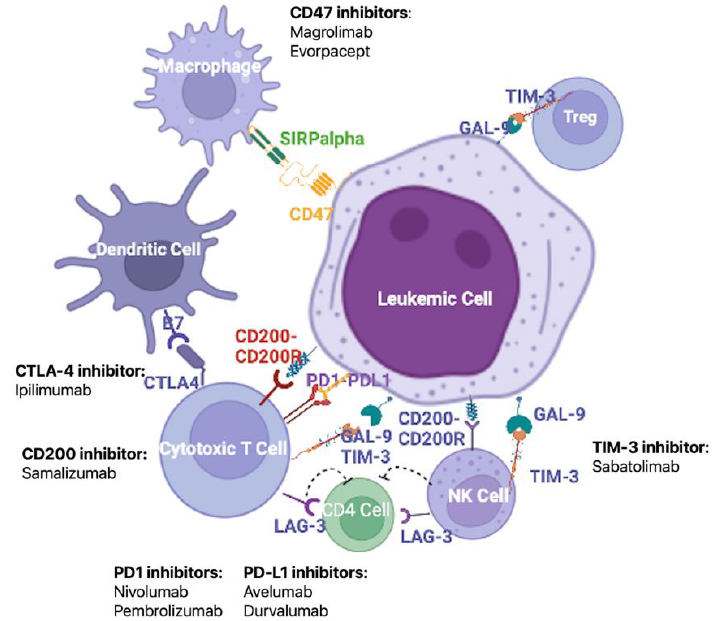
Figure 2. Major mechanisms of the maintenance of immune tolerance and potential therapeutic targets. Given the pivotal role of LSC-induced immune escape in the development and relapse of AML, an important treatment strategy to restore the function of anti-tumor immune cells is the blockade of immune checkpoints by monoclonal antibodies. Among the most promising targets are CD47, cytotoxic T-lymphocyte-associated protein 4 (CTLA-4), CD200, the PD1/PD-L1 axis, and T-cell immunoglobulin and mucin domain-containing protein (Tim-3). Figure created in Biorender.com.